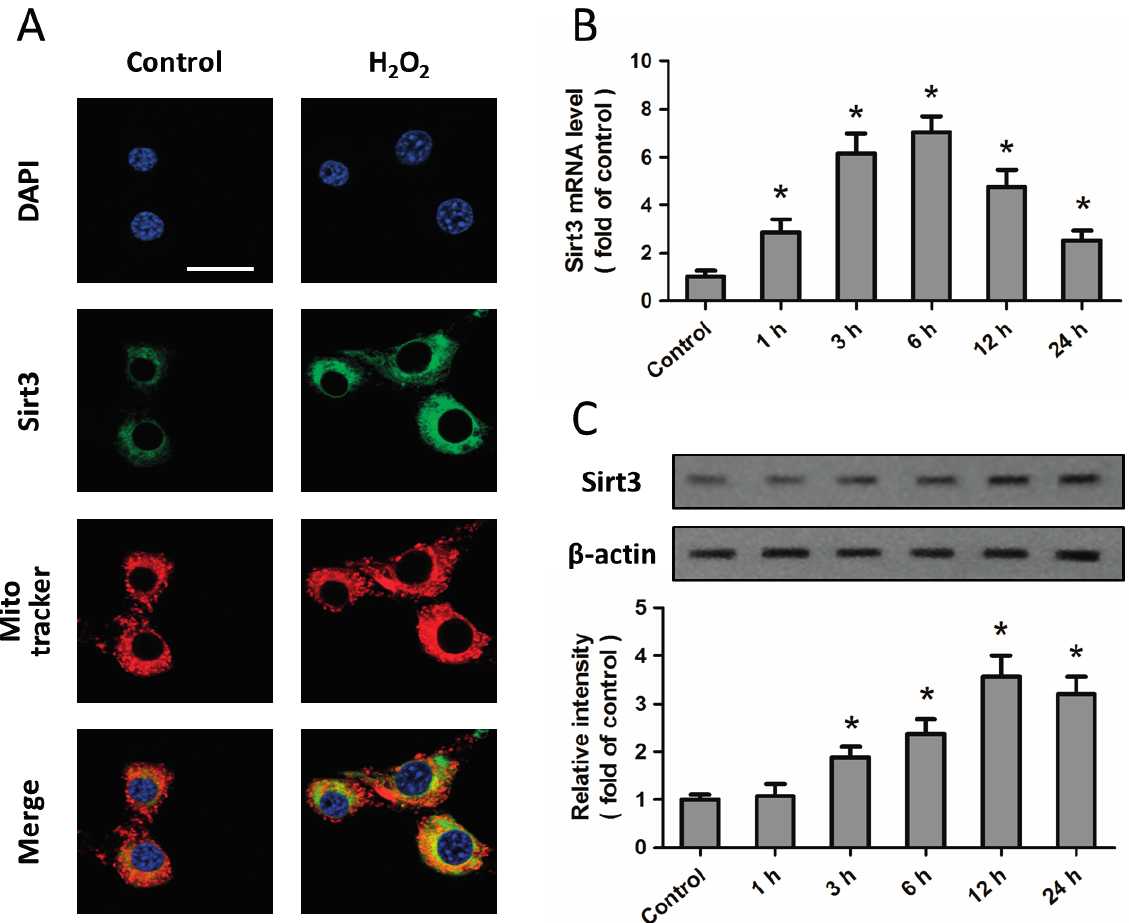
Figure 1. Expression of Sirt3 after H neurons were treated with 0.1 mM H Sirt3 was detected by immunofluorescence staining for Sirt3 (green), Merge (yellow); mitochondria (red) and DAPI (blue) ( A ); The expression of sirt3 mRNA ( B ) and protein ( C ) was measured by Real-Time RT-PCR and Western blot, respectively. Scale bar: 50 μ m. Data are shown as mean ± SD of five experiments. * p < 0.05 vs.